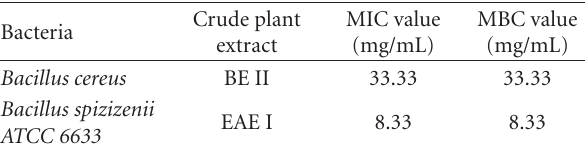
Table 3: In vitro activity of pathogenic bacteria for MIC and MBC values (mg/mL).